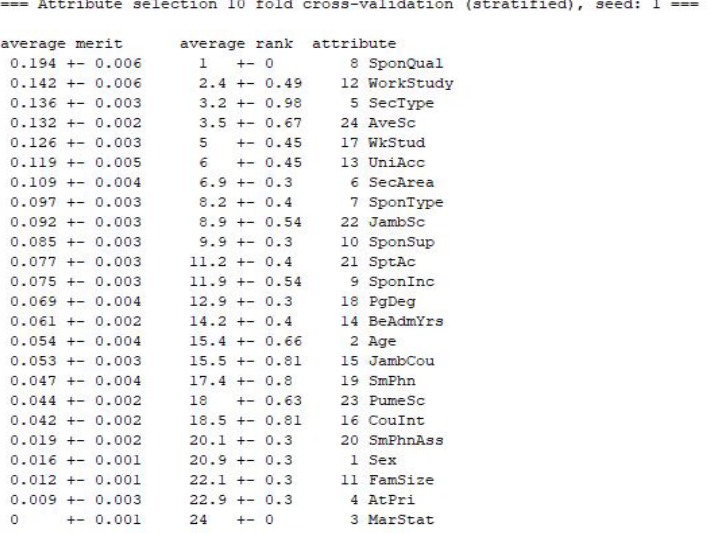
Figure 13: Results from gain ratio feature selection